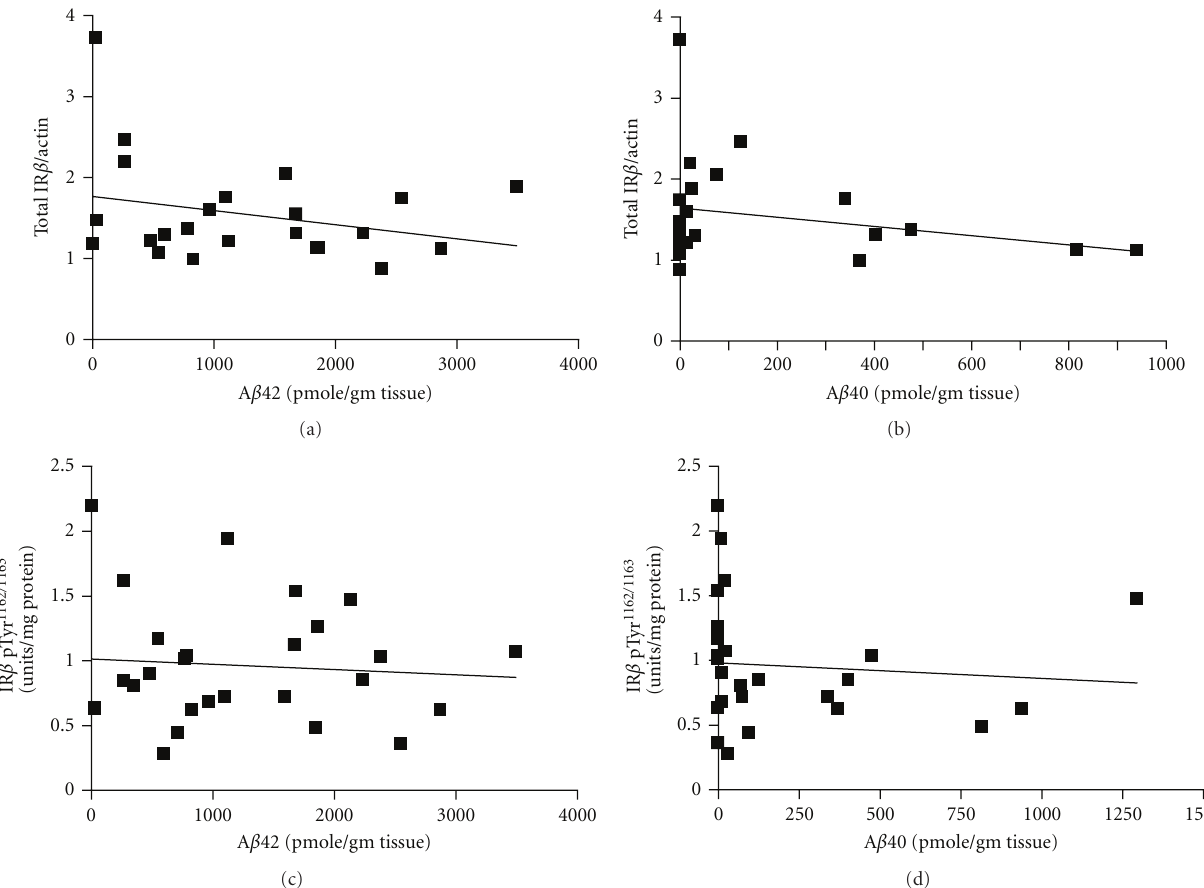
Figure 3: Total IR β and [Tyr1162/1163]-phosphorylated IR β contents in the hippocampal formation are not correlated with the contents of A β peptides. In ((a) and (b)), correlation analysis of total IR β content with contents of A β 1–42 (a) and A β 1–40 (b) peptides in the hippocampal formation. In ((c) and (d)), correlation analysis of [Tyr1162/1163]-phosphorylated IR β contents with A β 1–42 (c) and A β 1–40 (d) peptides in the hippocampal formation. In ((a)–(d)), solid line represents the best-fit correlation between IR β or [Tyr1162/1163]-phosphorylated IR β with β 1–42 or A β 1–40 peptides. Pearson correlation analysis; P = . 205 and .271 for IR β contents with A β 1–42 and A β 1–40 , respectively; P = . 684 and .681 for [Tyr1162/1163]-phosphorylated IR β contents with A β 1–42 and A β 1–40 ,